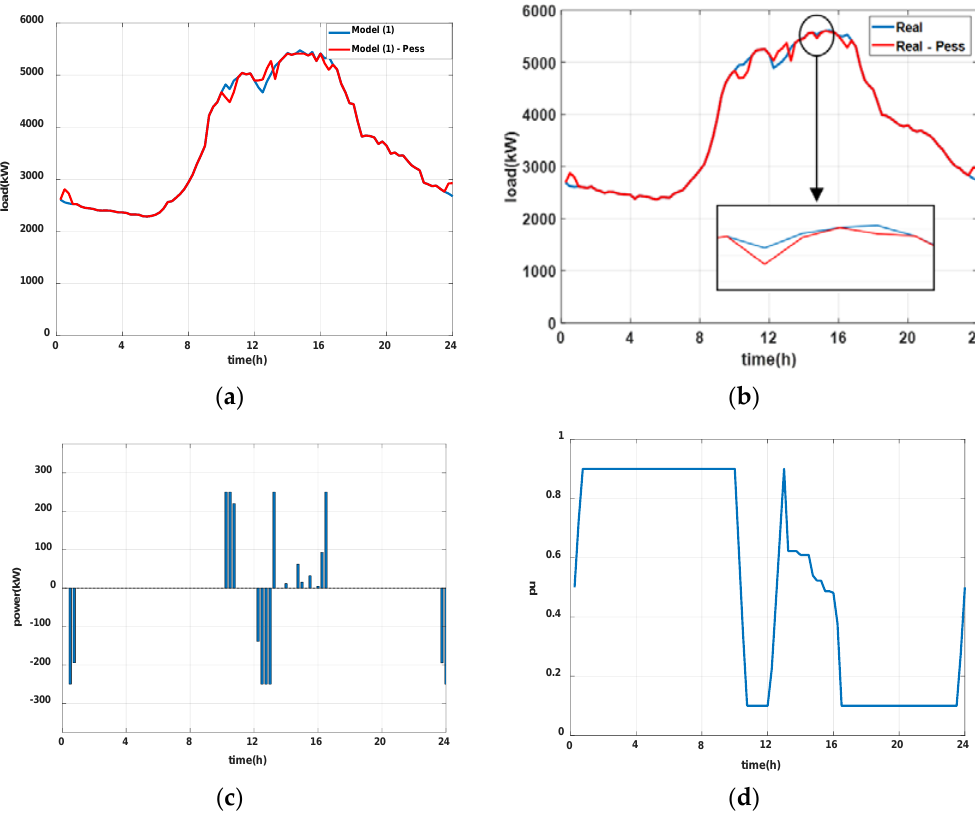
Figure 8. Case 2 simulation results. ( a ) Comparison of the predicted load with the actual load after applying the two-stage algorithm; ( b ) comparison of the actual load with the recorded load after applying the two-stage algorithm; ( c ) ESS power; and ( d ) SOC.